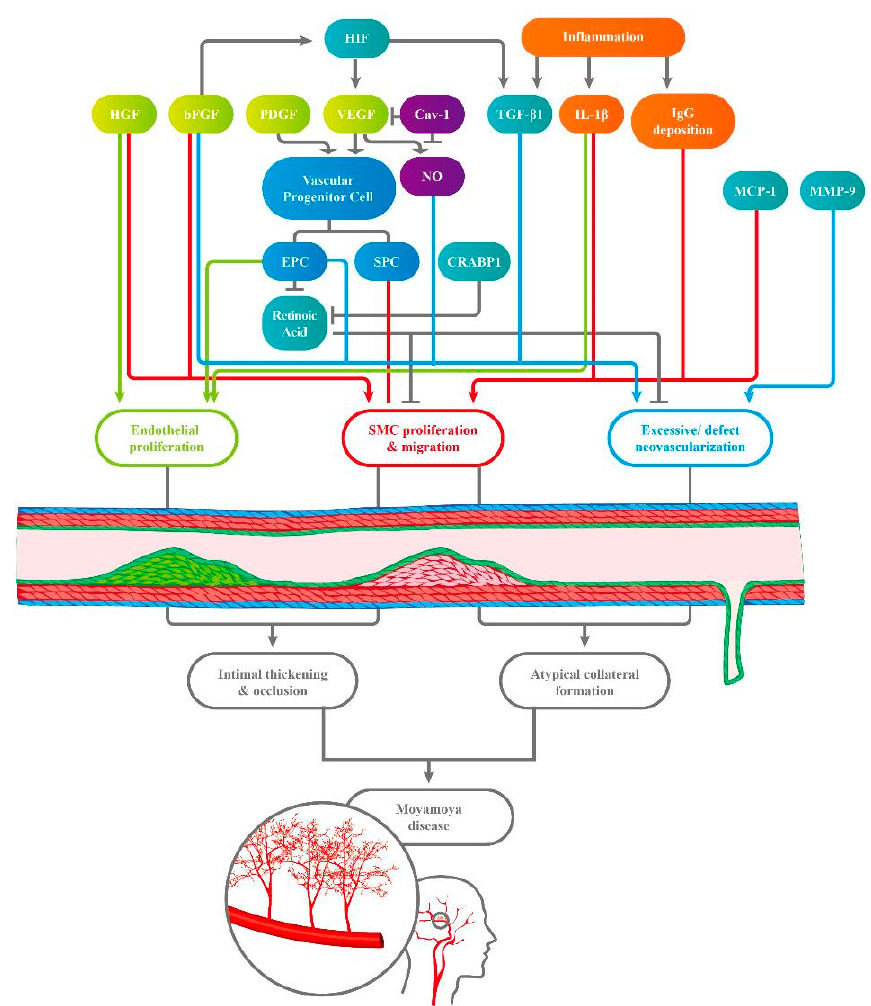
Figure 1. Various circulating factors interact, engendering endothelial proliferation, smooth muscle cell (SMC) prolifera- tion, and migration. These effects result in excessive but defective neovascularization, which causes intimal thickening and occlusion and compensatory atypical collateral formation, both of which are characteristics of Moyamoya disease (MMD). HIF, hypoxia-inducible factor; HGF, hepatocyte growth factor; bFGF, basic fibroblast growth factor; PDGF, plate- let-derived growth factor; VEGF, vascular endothelial growth factor; Cav-1, caveolin-1; TGF- β 1, transforming growth fac- tor; IL-1 β , interleukin-1 β ; IgG, immunoglobin G; EPC, endothelial progenitor cell; SPC, smooth muscle progenitor cell; CRABP-1, cellular retinoic acid binding protein; MCP-1, monocytes chemoattractant protein-1; MMP-9, matrix metallo- proteinase 9.).